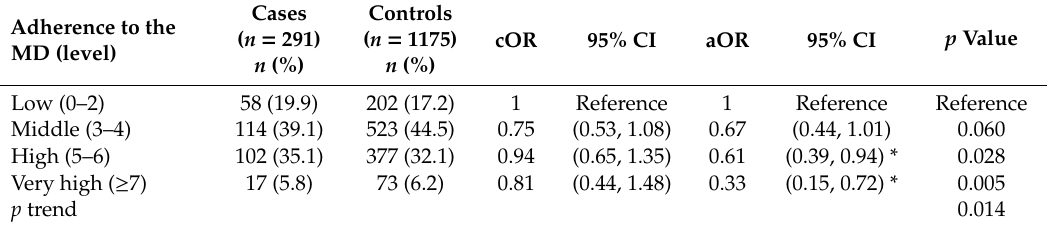
Table 4. Relationship between adherence to the Mediterranean diet and gestational diabetes